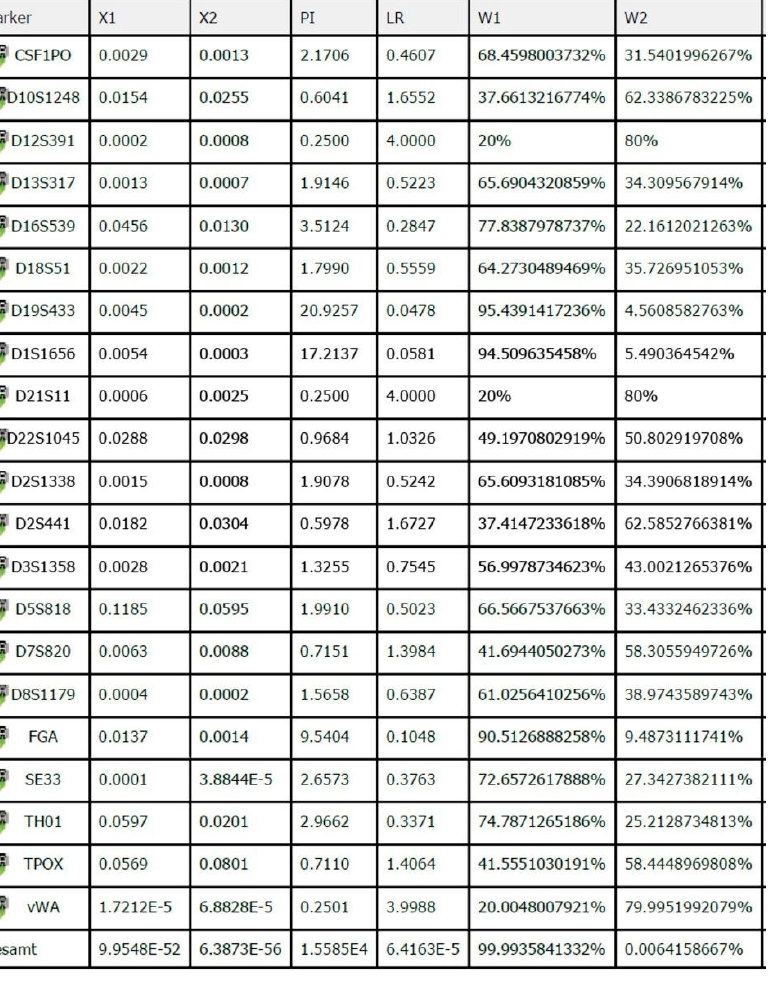
Figure 4. Screenshot of the results of statistical calculations for Hypothesis II, performed in GenoEvidence 3. Table 4. Results of the mtDNA haplotype concordance study between the NN male and Jann Dusza’s